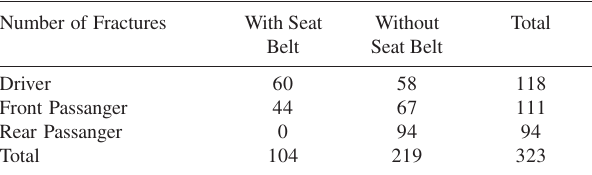
Table 2 - Number of fracture lines per group.